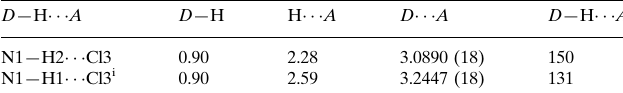
Hydrogen-bond geometry (A˚ , (cid:3) ).